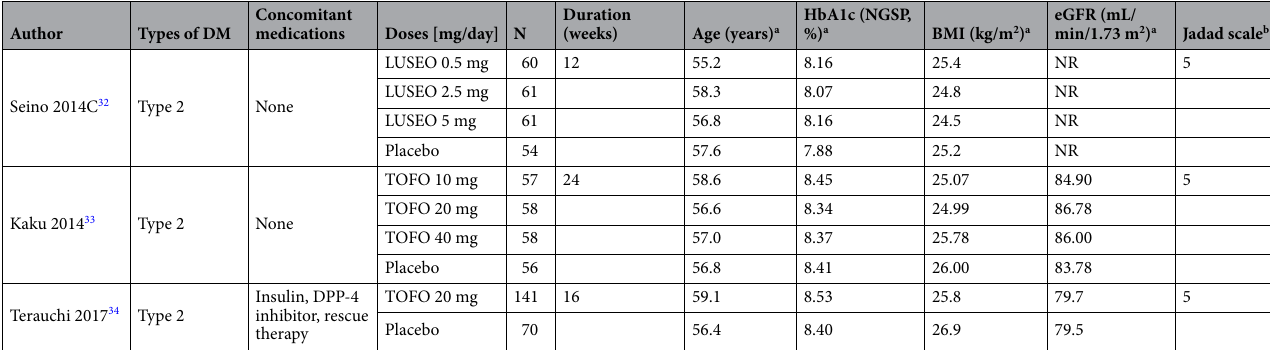
Table 1. Characteristics of 22 randomized controlled trials included in the meta-analysis. N number of patients, SGLT2 sodium-glucose co-transporter 2, BMI body mass index, DM diabetes mellitus, DPP-4 dipeptidyl peptidase-4, eGFR estimated glomerular filtration rate, CANA canagliflozin, DAPA dapagliflozin, EMPA empagliflozin, IPRA ipragliflozin, LUSEO luseogliflozin, TOFO tofogliflozin, NR not reported. *Data were extracted on week 24 before the up-titration of SGLT2 inhibitors was initiated. a Data were means. b Data were